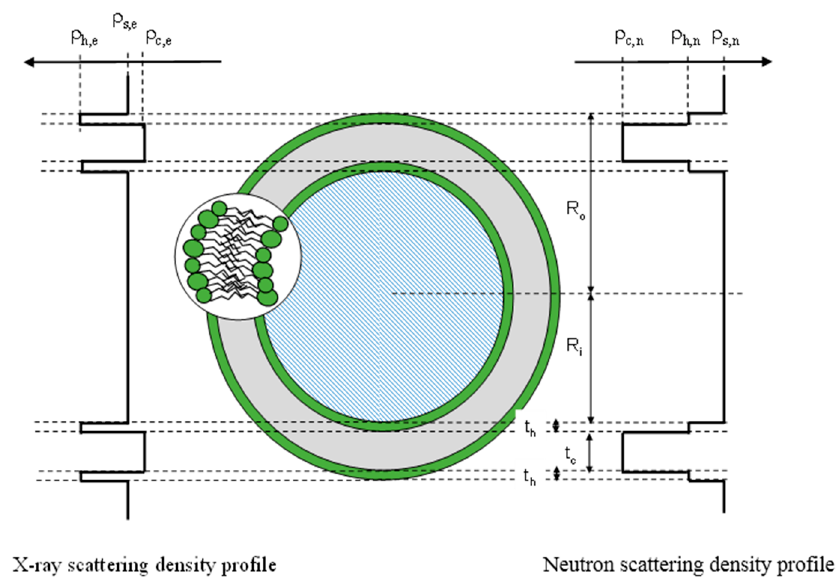
Figure 4. Comparison of the scattering length density profile of liposome for X-ray ( left ) and neutron ( right ). Adapted from [11].